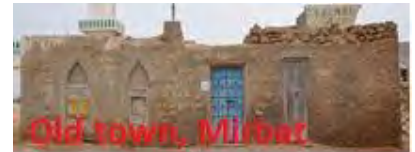
Figure 12. Fac¸ade’s photograph building location